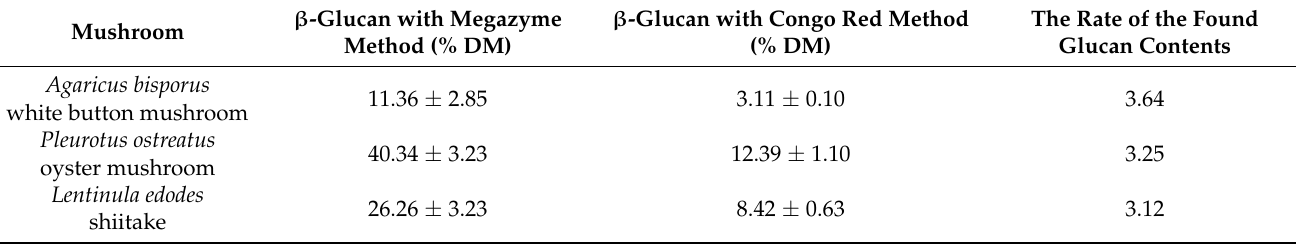
Table 4. β -glucan contents of three commercial cultivated mushrooms species analyzed by two methods